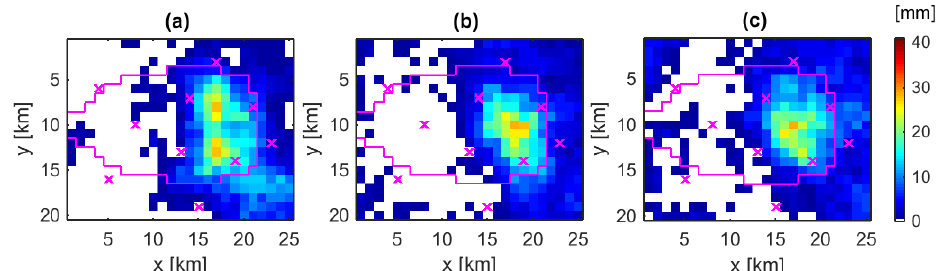
Figure 7. Event-based rainfall patterns conditioned at rainfall point observations only for the top three runoff simulations in Fig. 6.